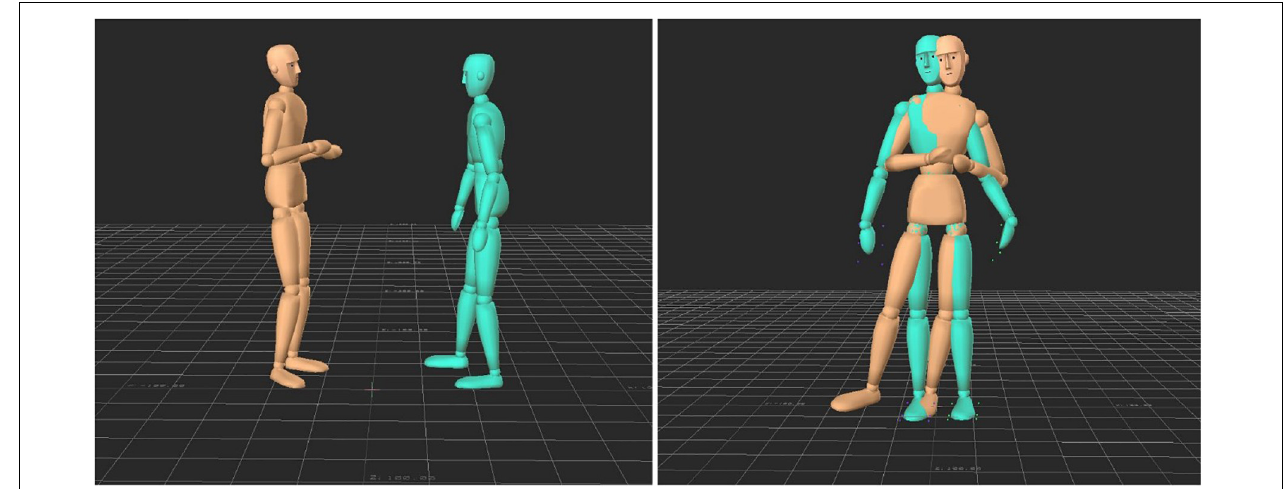
FIGURE 7 | Rationale for multidimensional comparisons: Both skeletons’ hips were constrained to the position as well as the y-rotation of a static object in the coordinate system origin, thus always pointing to the front. Postural differences were calculated as Euclidian distances between the corresponding joints of both partners for each